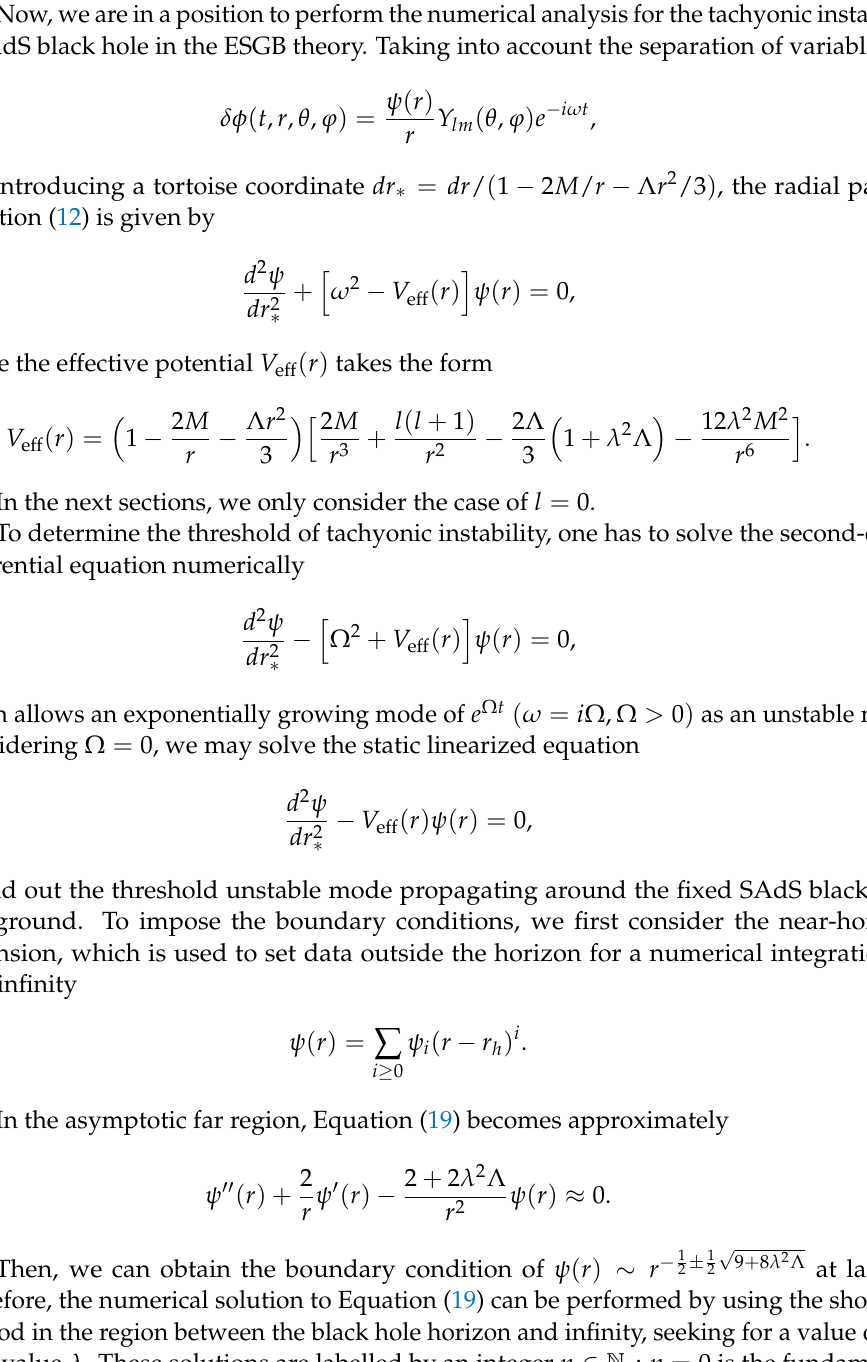
Figure 1b. In case of − Λ /3 → 0, the value of coupling parameter λ matches the